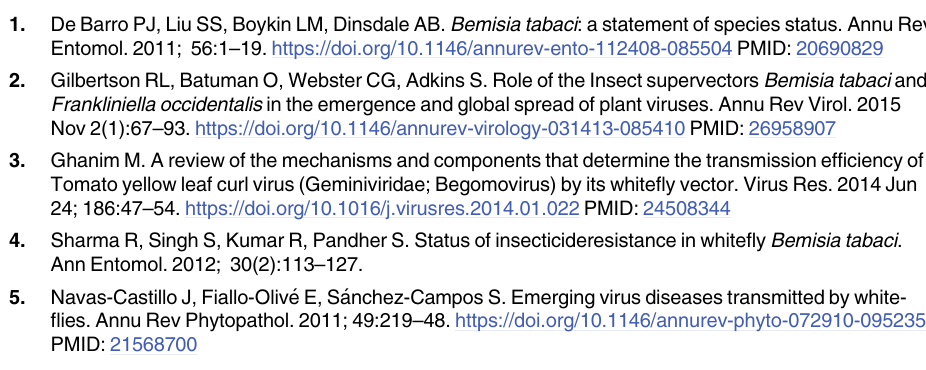
S1 Fig. A. Maintenance of virus free plants inside insect proof cages B. Clip inoculation setup for whitefly inoculation C. Cup cages for whitefly inoculation. S2 Fig. Morphological distinction of male ( ♂ ) and female ( ♀ ) whiteflies based upon size and shape of